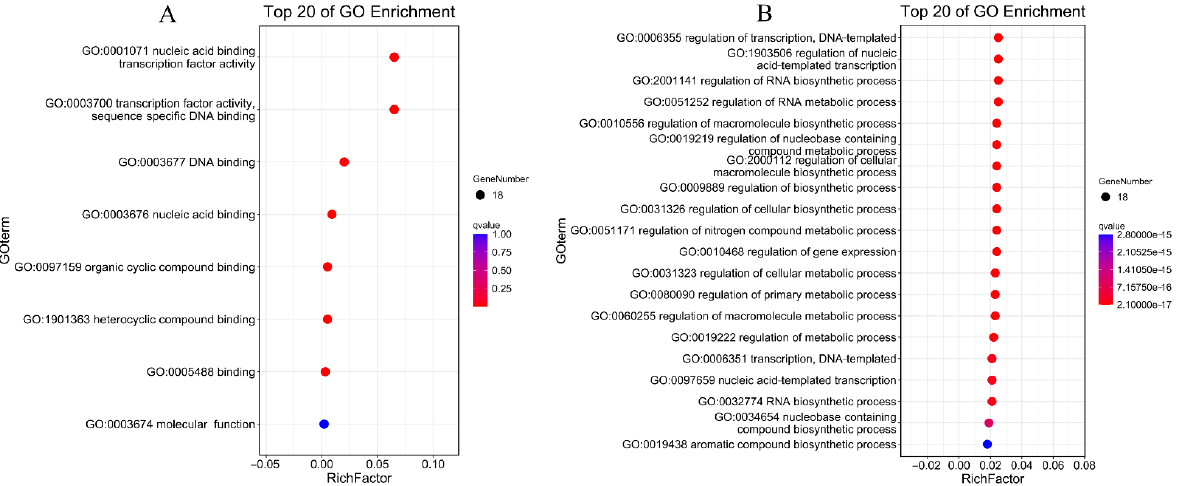
Figure 11. Top 20 significantly enriched GO terms for PdAP2/ERF-interacting proteins. ( A ): Molec- ular Function. ( B ): Biological Process. lar Function. ( B ): Biological